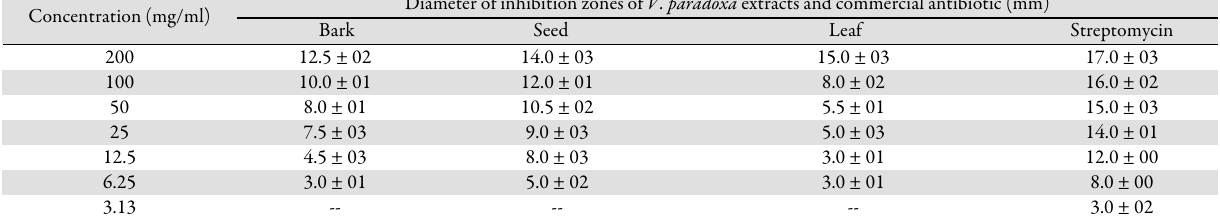
Table 3. Antimicrobial activity of V. paradoxa extracts against Escherichia coli Diameter of inhibition zones of V. paradoxa extracts and commercial antibiotic (mm) Concentration (mg/ml)